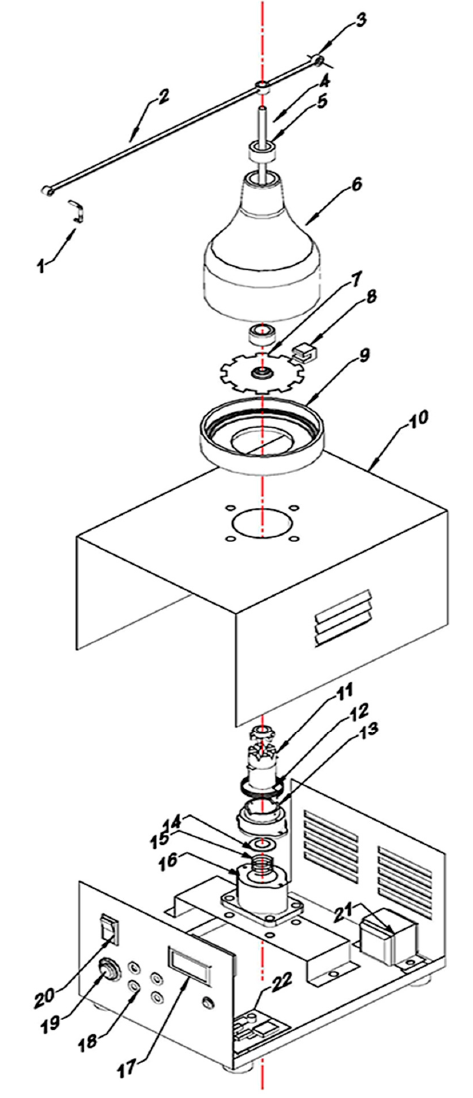
Figure 3. A detailed schematic diagram showing the components of the computerized flight-testing mill. ( 1 ) Brass connecter pole, ( 2 ) rotating arm, ( 3 ) counterweight, ( 4 ) spindle shaft, ( 5 ) brass bushing, ( 6 ) shaft base, ( 7 ) opaque plastic disc, ( 8 ) optoelectronic switch, ( 9 ) fixing base, ( 10 ) housing, ( 11 ) clutch, ( 12 ) spiral spring, ( 13 ) variable resistance, ( 14 ) brass flat washer, ( 15 ) stainless steel spiral spring, ( 16 ) electromagnet coil, ( 17 ) Liquid crystal display (LCD) of the digital counter, ( 18 ) signal outputs, ( 19 ) clutch actuation button, ( 20 ) power switch, ( 21 ) transformer, ( 22 ) electronic circuit of the